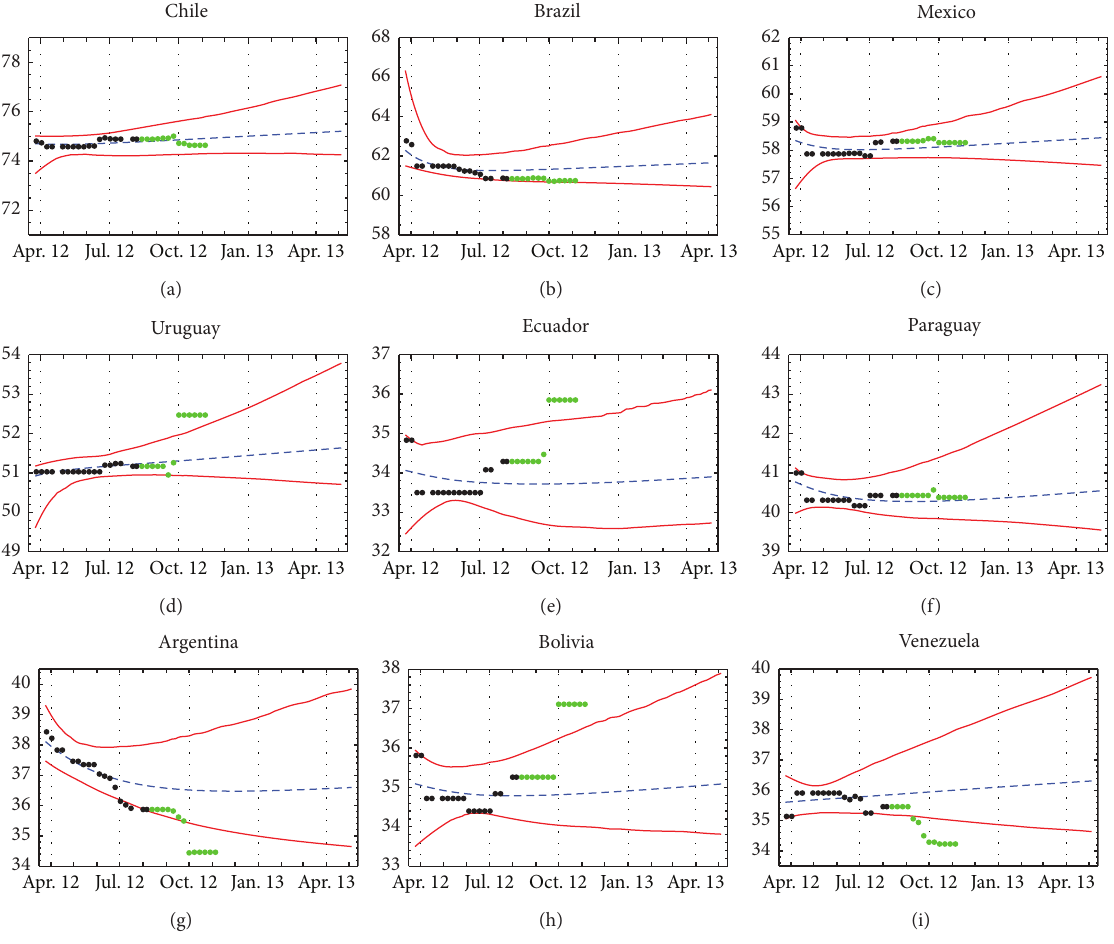
Figure 5: Probabilistic Country Risk Score forecasting for selected Latin American countries belonging to each cluster (cluster 1: Chile; cluster 2: Brazil, Mexico, and Uruguay; cluster 3: Ecuador; cluster 4: Paraguay, Argentina, Bolivia, and Venezuela). The dashed line is the mean of the 95% confidence interval and the red lines correspond to 95% confidence intervals between April 2, 2012, and May 5, 2013. The drawn black points are the known CRS of the 1st data set. The green points are the actual and current available data (from August 13, 2012, to November 5, 2012) used in order to validate the model, the 2nd data set. Notice that every plot has its own numerical range in the vertical